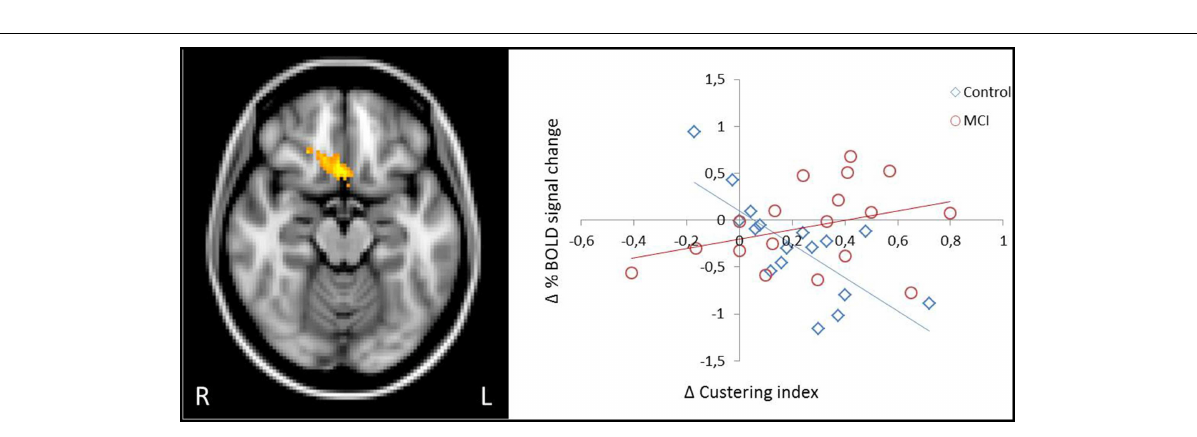
increase in strategic behavior was predictive of greater decrease in activation in the OFC, whereas in MCI increase in behavior was predictive of increased